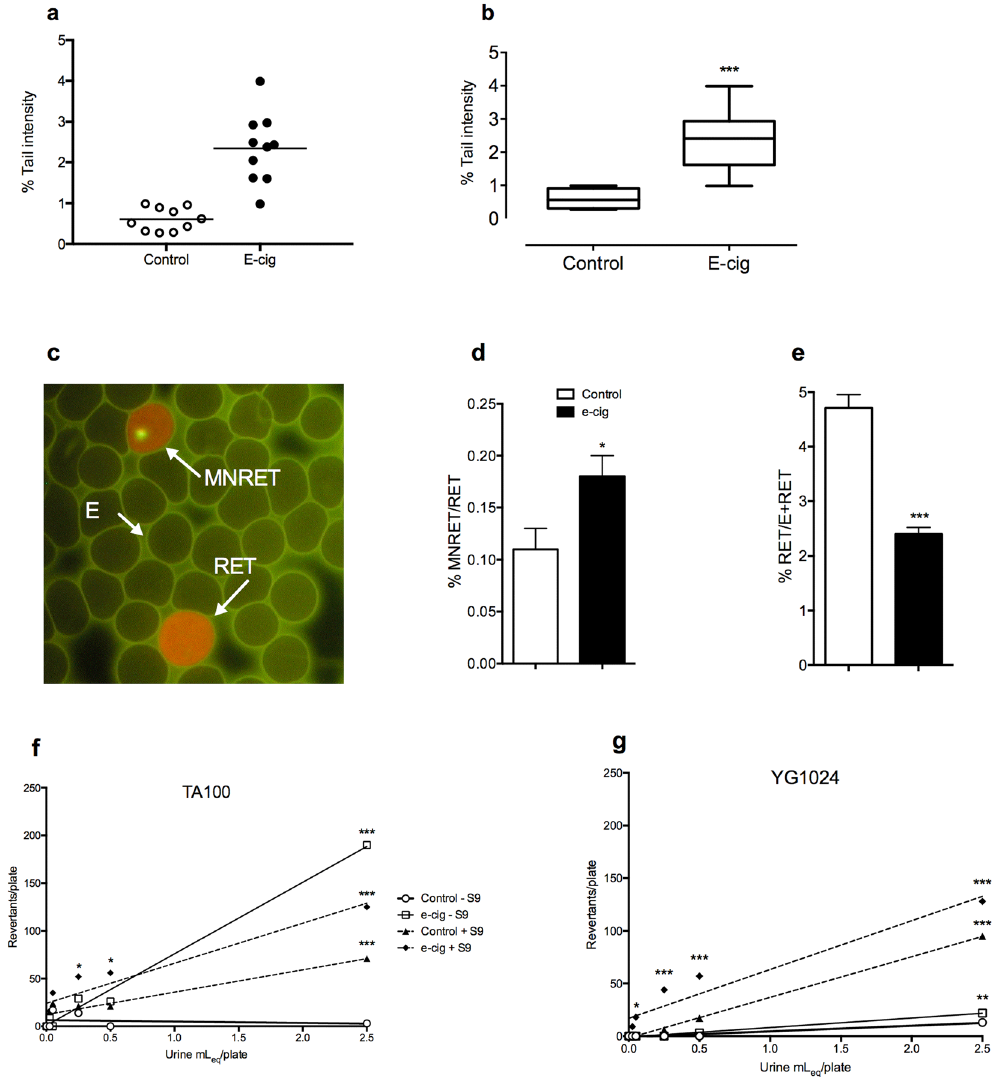
Figure 3. Genotoxicity of e-cig vapour. ( a ) Distribution of individual median TI% for the alkaline Comet assay. ( b ) Box-plot of TI%: primary DNA damage increase ( P < 0.001). ( c ) Representative image of micronuclei (yellow MN-RET, orange RET, green erythrocytes (E). ( d , e ) MN-RET vs RET and RET vs E plus RET; MN-RET vs RET increased ( P < 0.05); hematopoietic depression up to 50% loss, as RT fraction of total red blood cells, ( P < 0.001). Error bars ± S.D. * P < 0.05; *** P < 0.001 two-tailed t -test. ( f , g ) Urinary mutagenesis: TA100